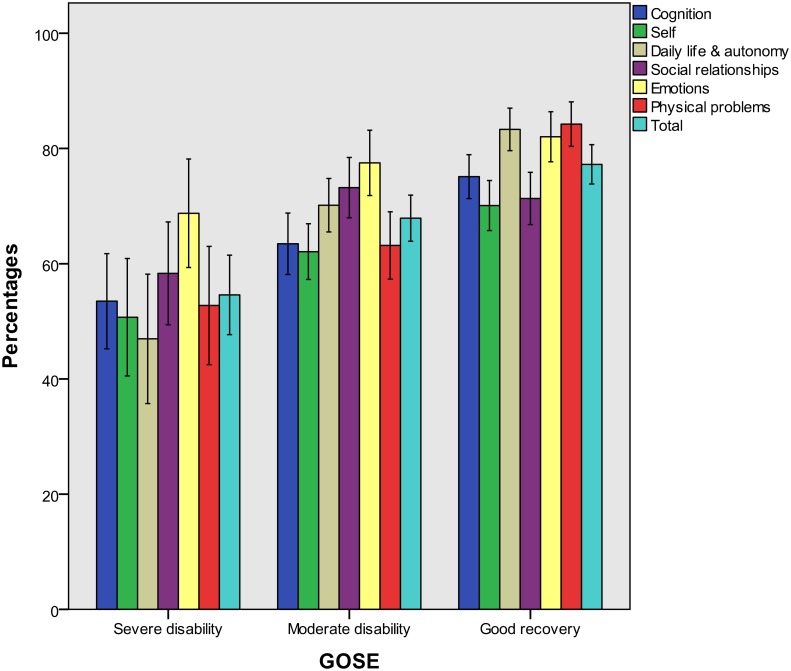
QOLIBRI scale percentage scores (means and 95% confidence intervals) for GOSE groups.